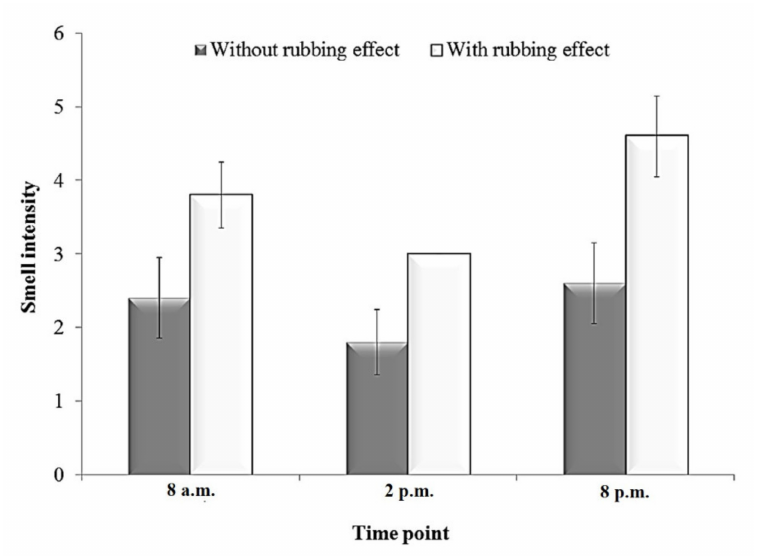
Figure 2. Effects of rubbing on the level of scent emitted by the leaves of Plectranthus amboinicus detected at a distance of 5 cm from the human nose. Scent intensity was evaluated based on a scale that ranged from 0 to 6, with 6 as the strongest and 0 as no scent